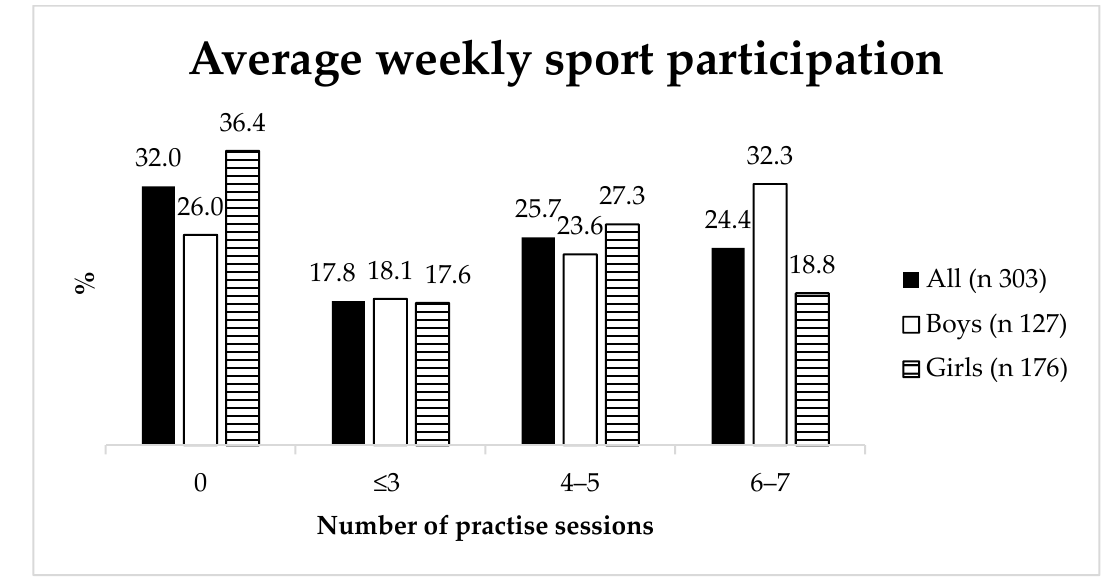
Figure 1. Number of practice sessions per week in total and by sex. Table 2. Linear regression results with organized sport participation (OSP) as the dependent